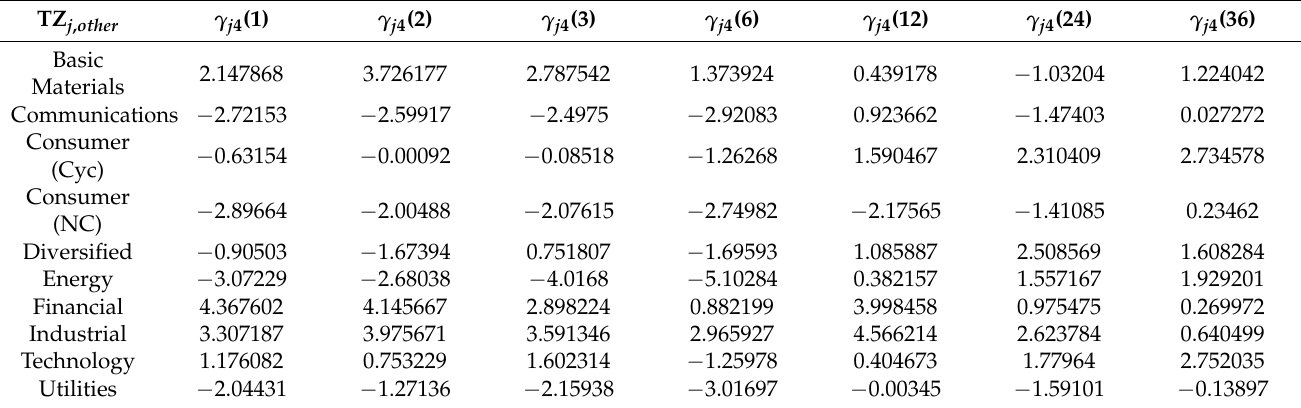
Table 5. Maximum pseudo-likelihood estimates for γ j 4 (l) .